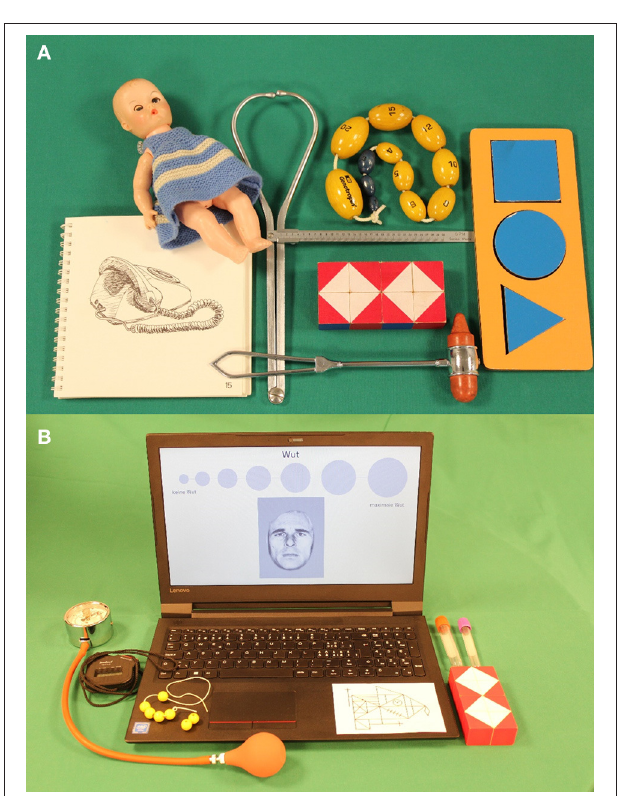
FIGURE 4 | Illustration of example assessment tools used for the ZLS assessments. (A) ZLS-Childhood. (B) ZLS-Adulthood (first assessment wave).